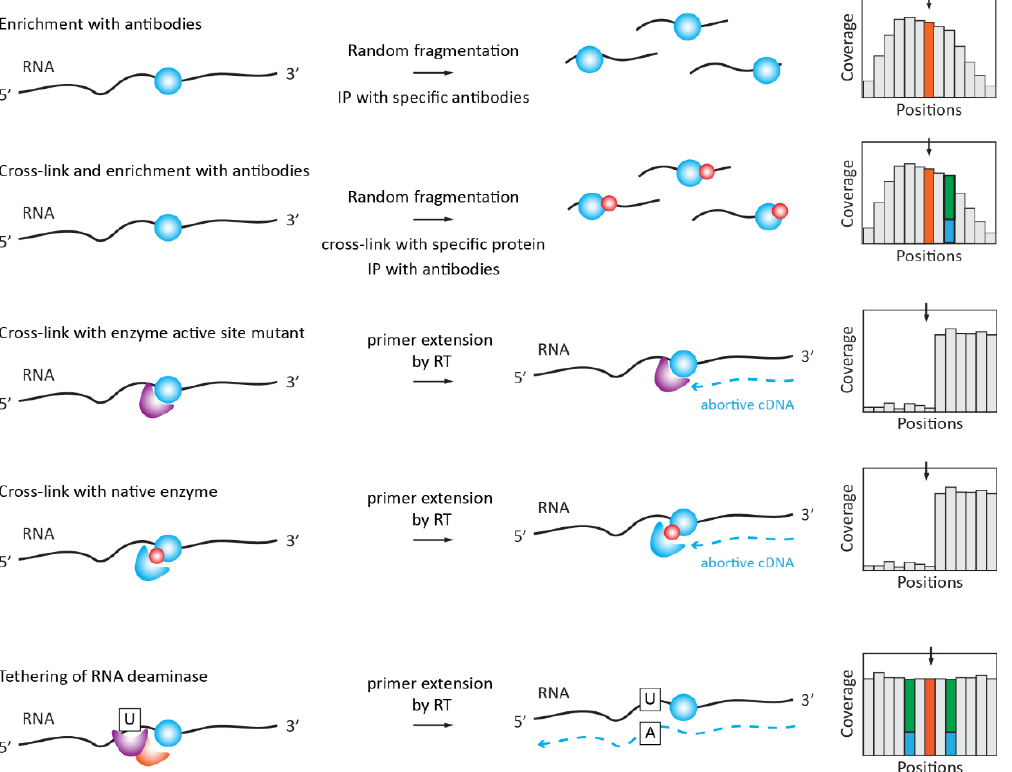
Figure 3. Detection of RNA modifications by immunoaffinity and other affinity-related methods. ( A ): A classical Me-RIP approach first applied to m 6 A and further extended also to non-methylated modified nucleotides. RNA is fragmented and the modification-containing fraction is enriched by immunoprecipitation. The signal of Me-RIP is somehow asymmetric, and a modified nucleotide may be displaced from the peak summit. Panel ( B ): immunoprecipitation-based individual- nucleotide resolution UV crosslinking and immunoprecipitation/Photoactivatable Ribonucleoside-Enhanced Crosslinking and Immunoprecipitation (iCLIP)/PAR-CLIP approaches using the covalent cross-linking of the specific antibody to RNA in the proximity of RNA modification. RT signature (shown in blue/green and resulting from RNA/protein cross-link may be visible in proximity to the modified nucleotide. Panel ( C) : A covalent cross-linking with the modified residue when the enzyme active site mutant is used. Described for m 5 C and m 5 U methylating enzymes, which use a two-step reaction mech- anism. Panel ( D ): cross-linking with the native enzyme may be achieved by the incorporation of non-natural nucleotides in RNA in vitro or in vivo (metabolic labeling). Panel ( E ): Reader protein for RNA modification is fused with the RNA deaminase domain (APOBEC) and, thus, tethered to the modified RNA residue (shown in orange), inducing partial C → U deamination in close proximity to RNA modification. These partial deamination signatures are visible in the sequencing profiles (shown in green/blue).